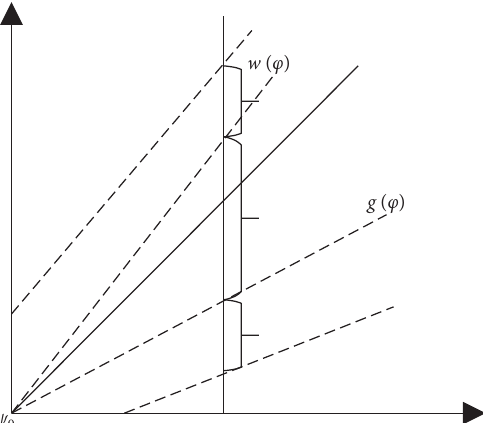
Figure 4: Game intervals of traders with different types of transaction